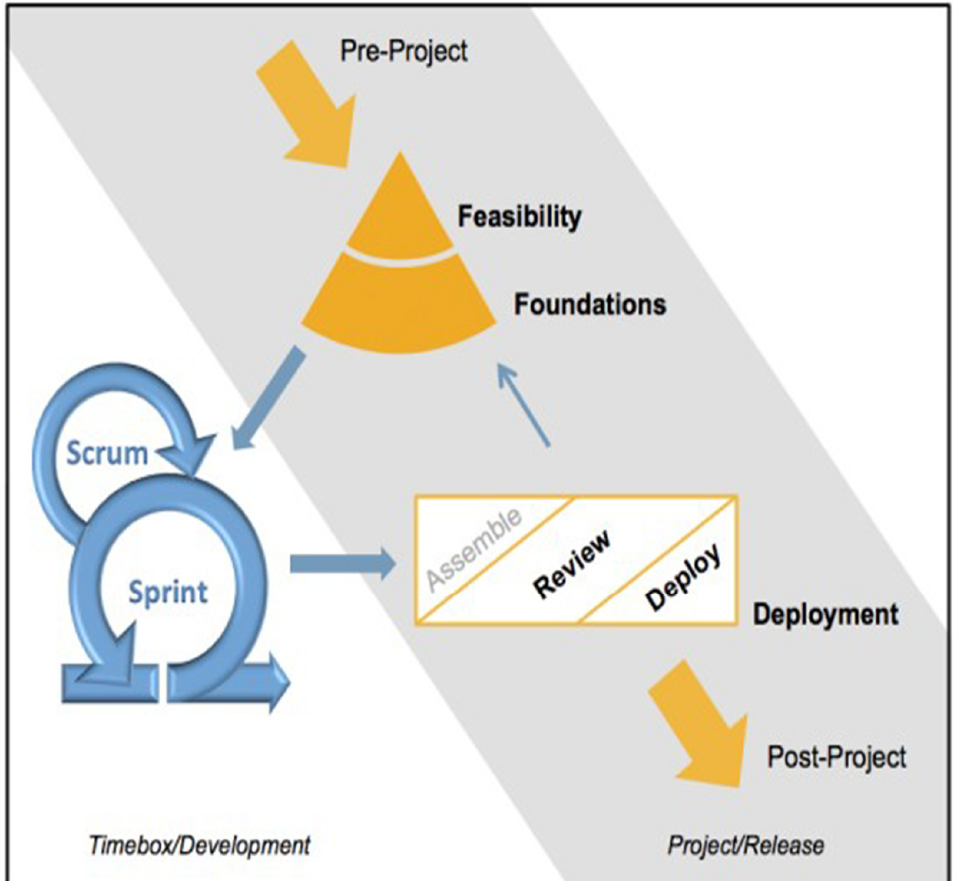
Figure 3. DSDM Agile Project Framework. Source: Reprinted with permission from [81]. 2014, Agile Business Consortium.